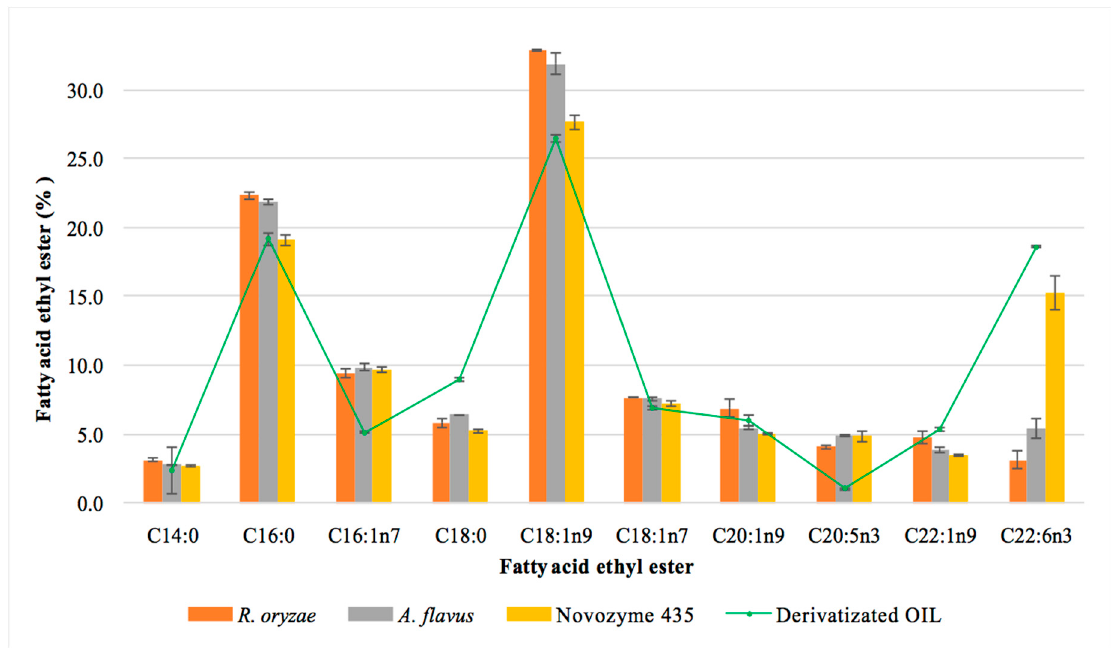
Figure 4. Effect of the biocatalyst on the profile of the main fatty acid ethyl esters obtained in reaction 72 h. OIL: total content of the corresponding ethyl ester in the monkfish liver oil.